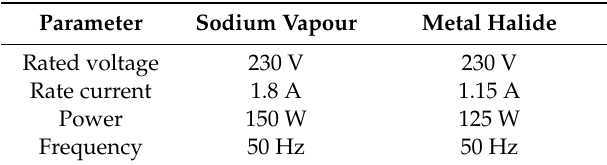
Table 4. Lamps characteristics.